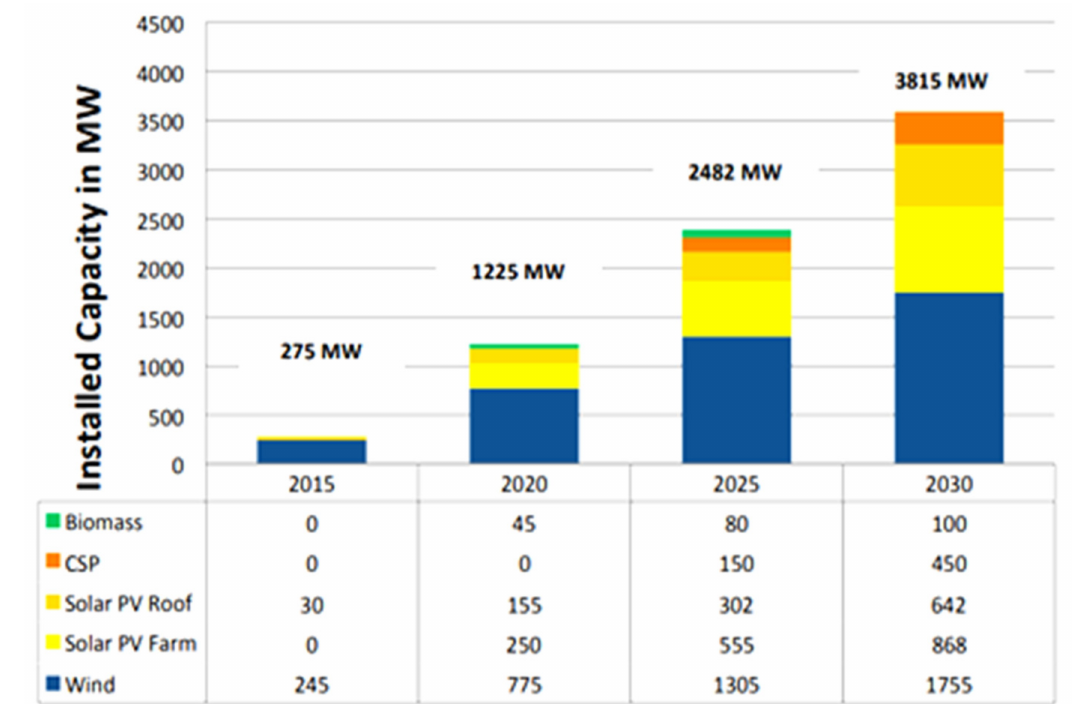
Figure 5. Install capacity evolution according to the Tunisian solar plan.